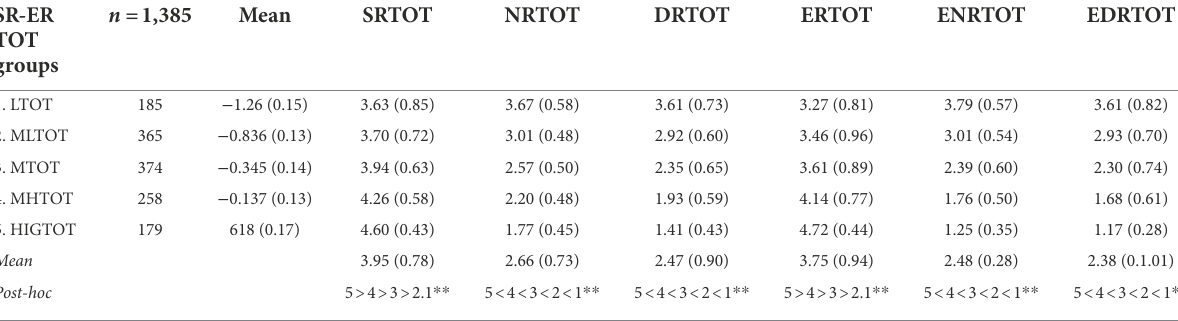
TABLE 8 Descriptive statistics for the groups formed with the total scores ( n = 1,385).